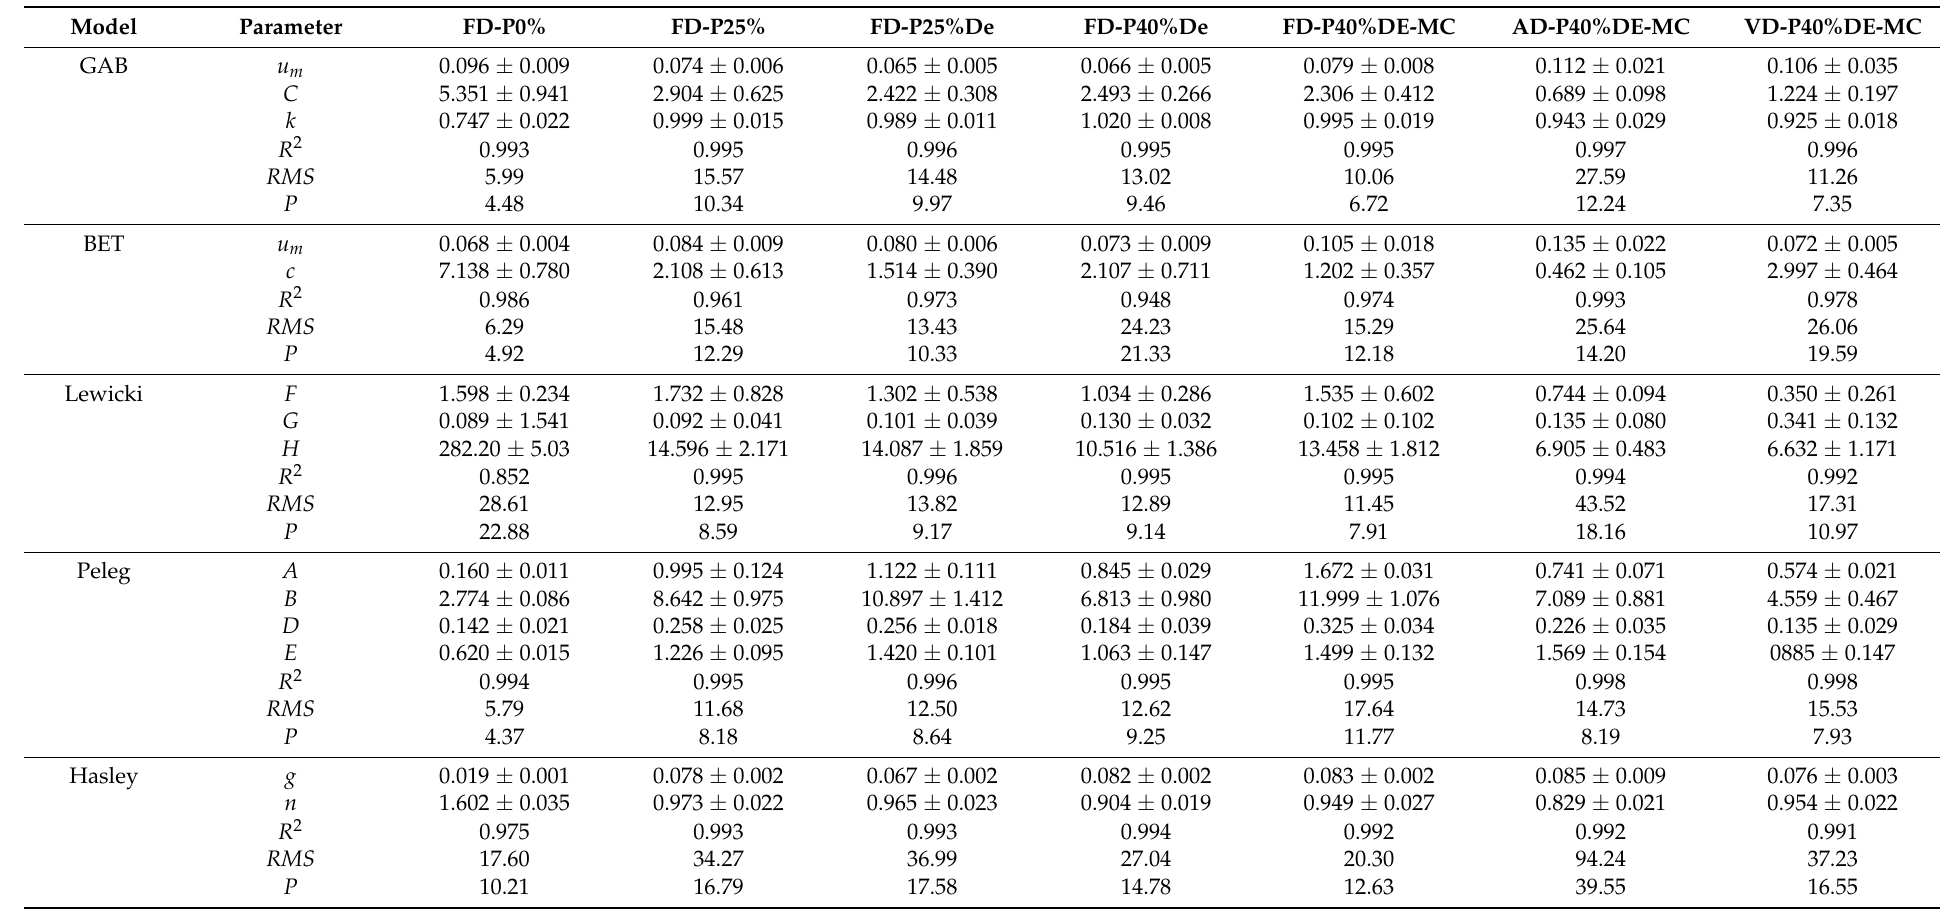
Table 3. Parameters of sorption isotherms models with goodness fit coefficients ( R 2 , RMS , P ) of freeze-dried (FD), air-dried (AD) and vacuum-dried (VD) gels.